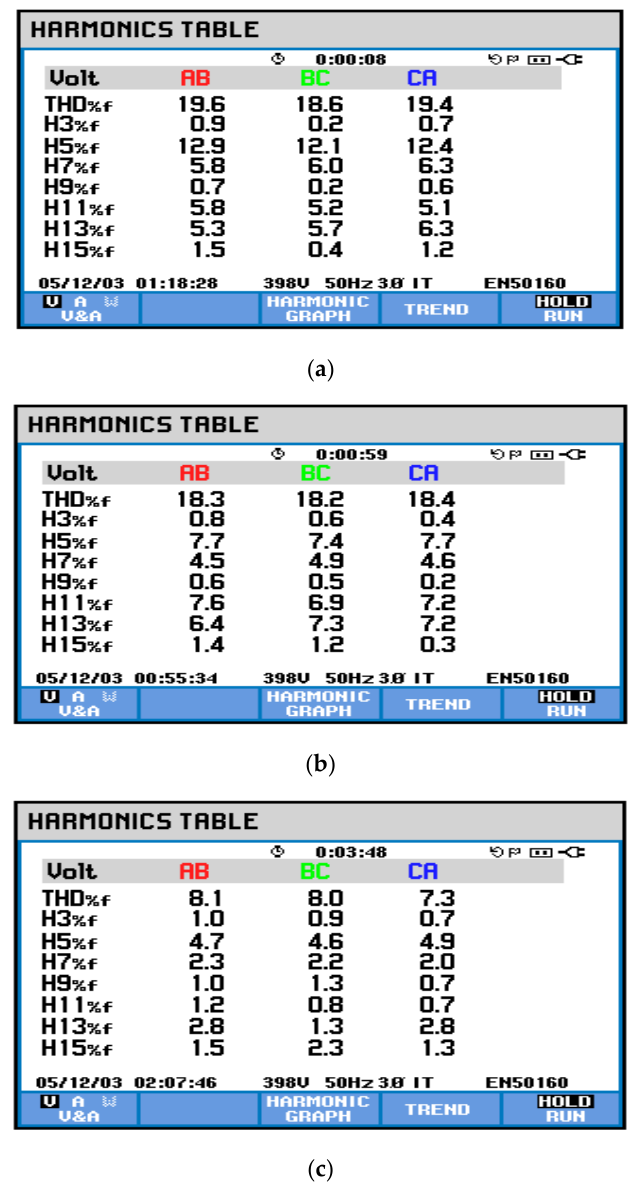
Figure 12. The experimental comparison results of the output voltage. ( a ) The FFT of the voltage without any compensation algorithm; ( b ) The FFT of the voltage with the conventional voltage compensation algorithm; ( c ) The FFT of the voltage with the proposed compensation algorithm.